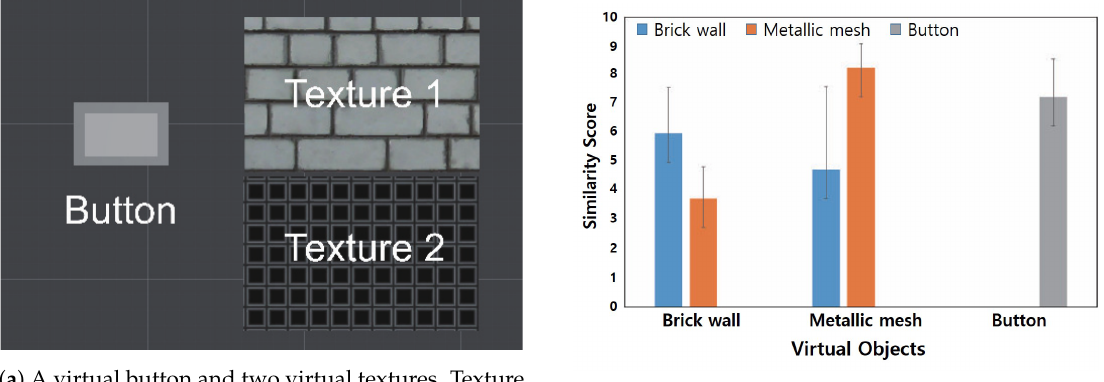
Figure 9. The stimuli used in experiment two for rendering textures and a button. The textures were rendered using high frequency vibrations and the button was rendered using impact response of the haptic